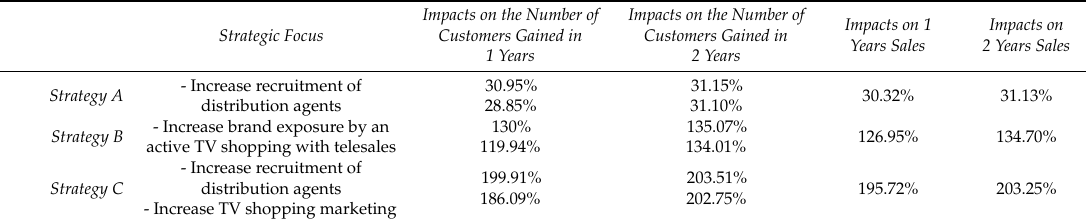
Table 2. Impact analysis of market development strategy (based on demonstrative simulations). Strategic